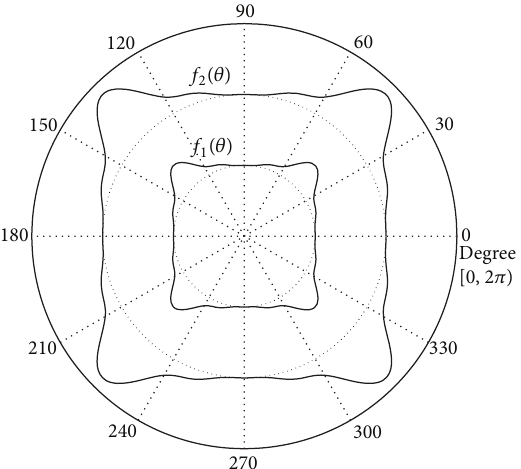
Figure 4: The approximate boundaries of the cloak.